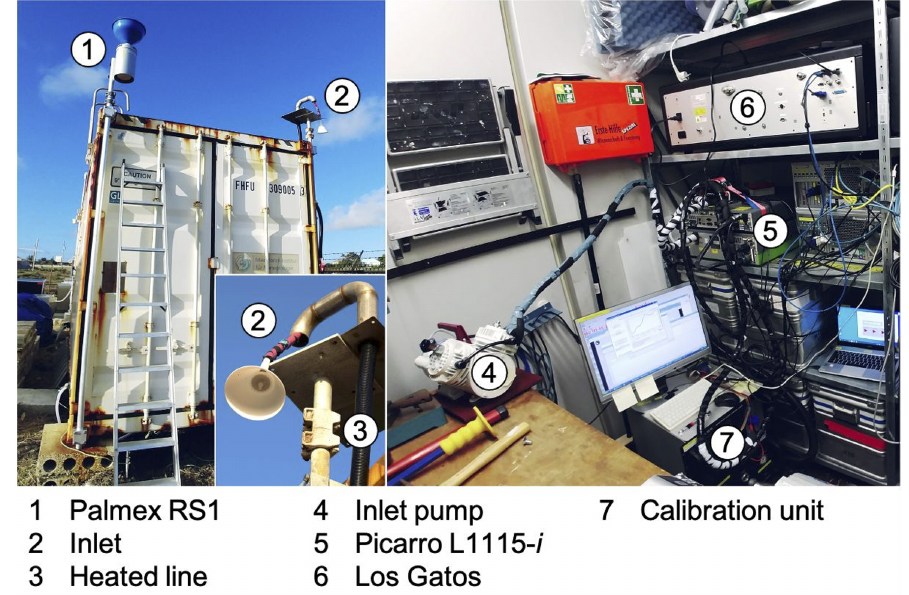
Figure 4. Isotopic sampling installations at the Barbados Cloud Observatory were composed of a Palmex RS1 rainwater collector (#1) and two water vapor isotopic analyzers (fabricated by Picarro (#5) and Los Gatos Research